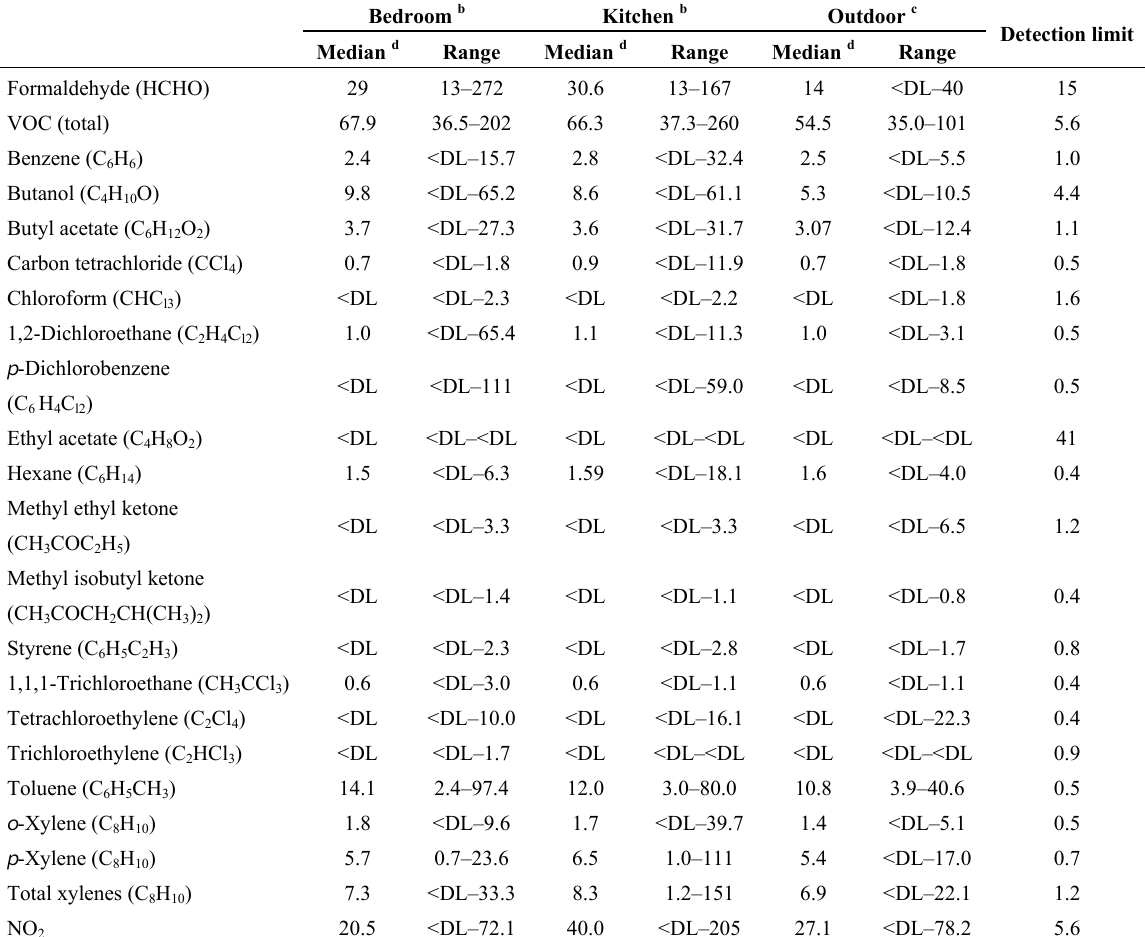
Table 2. Indoor concentrations a of HCHO, VOCs, and NO ( μ g/m 3 , 5–23 August